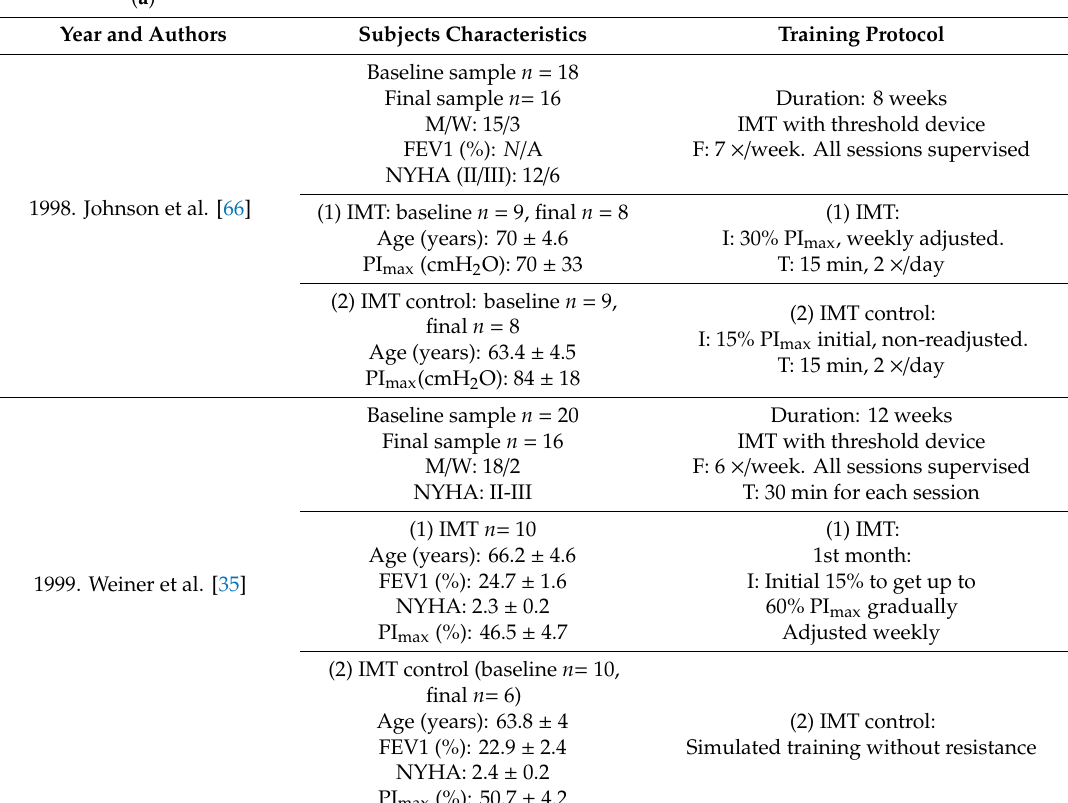
Table1. a. Characteristicsoftherandomizedclinicaltrialswithoutotherinterventions; b. Characteristics of the randomized clinical trials with other interventions; c. Characteristics of the quasi-experimental studies and the clinical